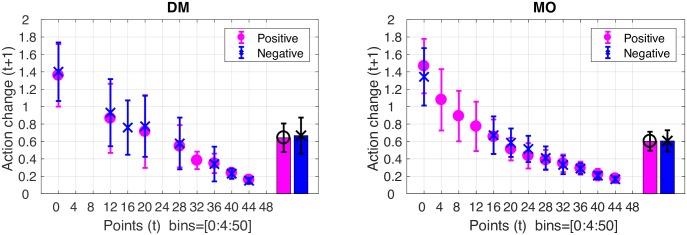
Action change following positive and negative feedback.Action change on attempt (t + 1) following a score on attempt t in the positive (pink circle) and negative (blue cross) feedback conditions for the DM (left) and MO task (right). Mean action change for each participant for the positive condition (pink bar with circle) and the negative condition (blue bar with cross) in the DM task (left) and the MO task (right).